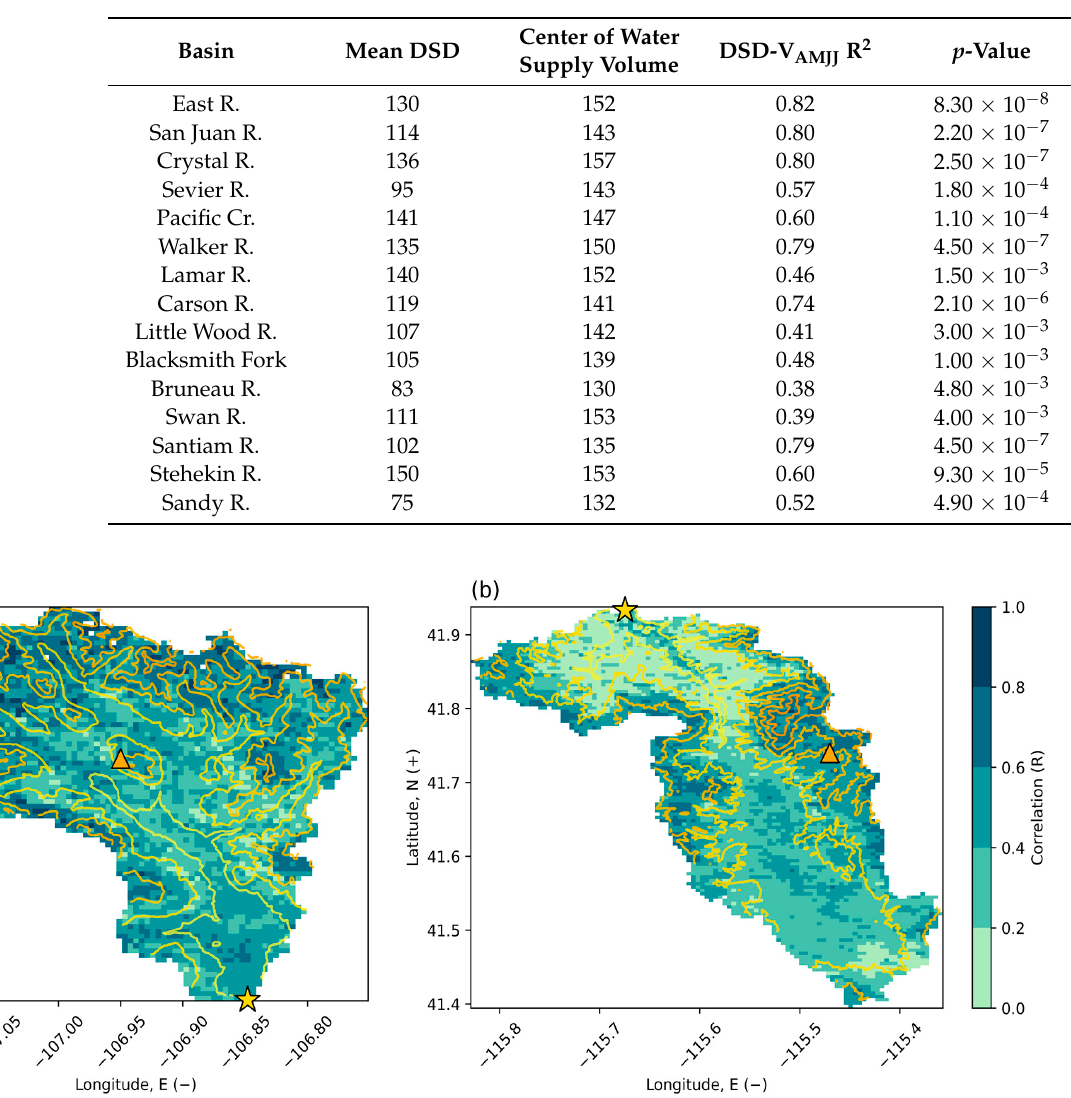
Table 3. Relationships between mean DSD, center of water supply volume, and V AMJJ for the 15 selected study basins. R 2 and p -value from OLS model fit statistics using all years of available spatially aggregated DSD and USGS stream gage data. Basins are sorted from highest to lowest elevation at their USGS stream gage.